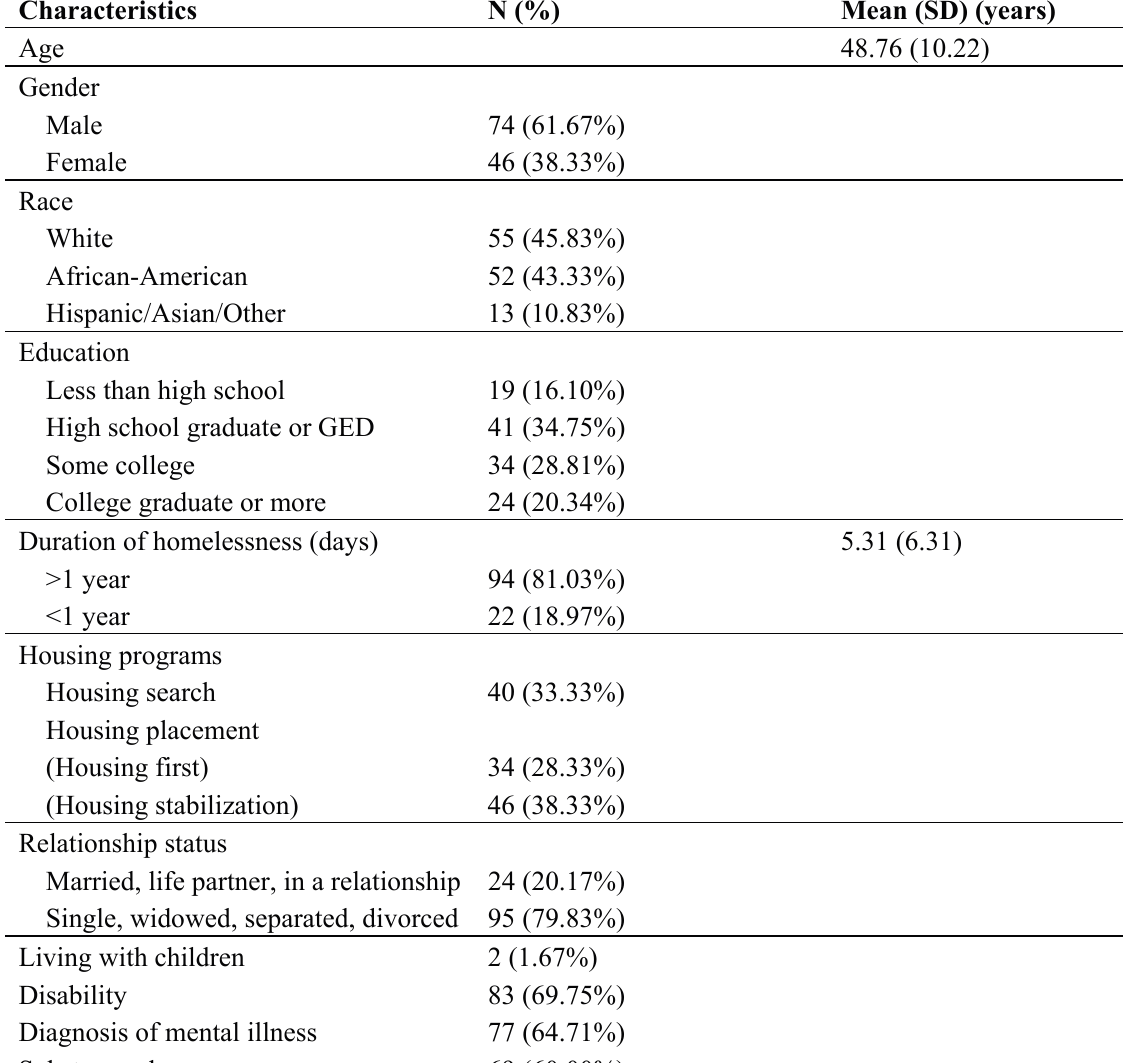
Table 1. Characteristics of the sample (n =